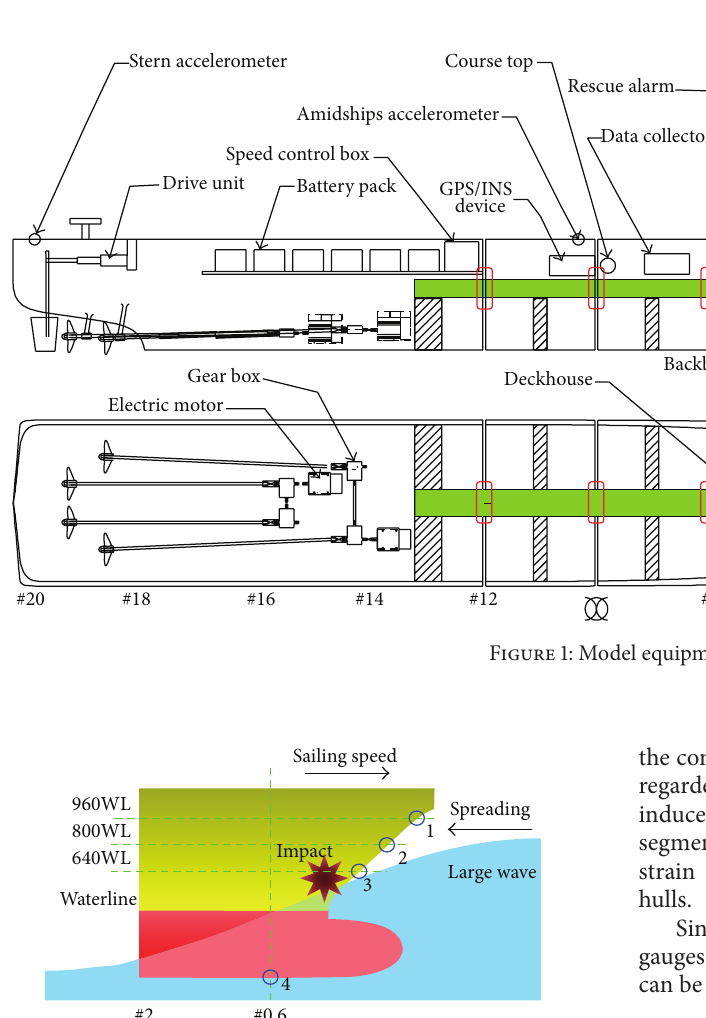
Figure 2: Sketch of bow-flare impact